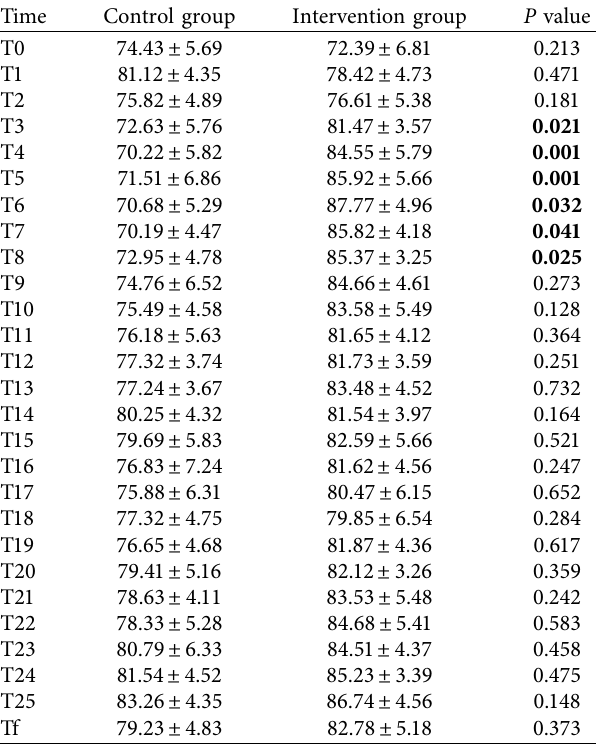
Figure 2: Mean arterial blood pressure variation in both groups. Table 3: Mean heart rate variation in both